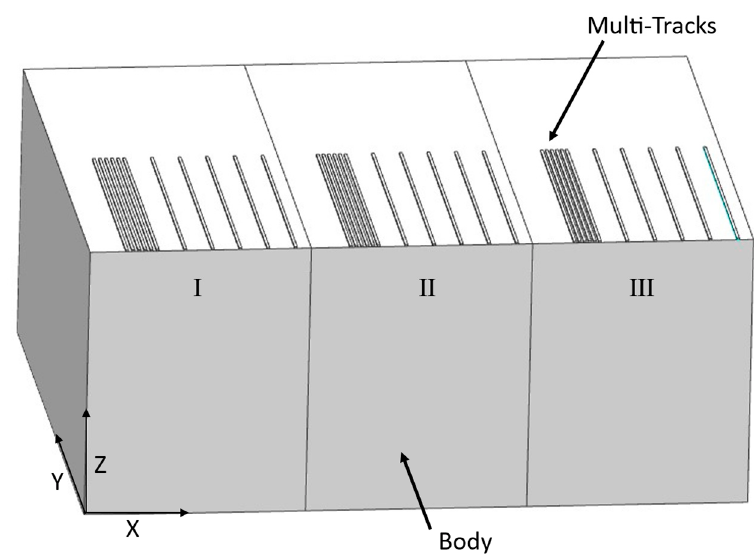
Figure 9. Specimens for multi-tracks analysis.